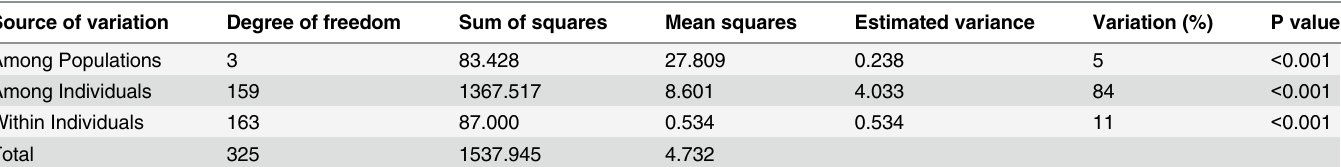
Table 5. Analysis of molecular variance among and within populations, and within individuals of Colletotrichum gloeosporioides populations based on 23 SSR loci.